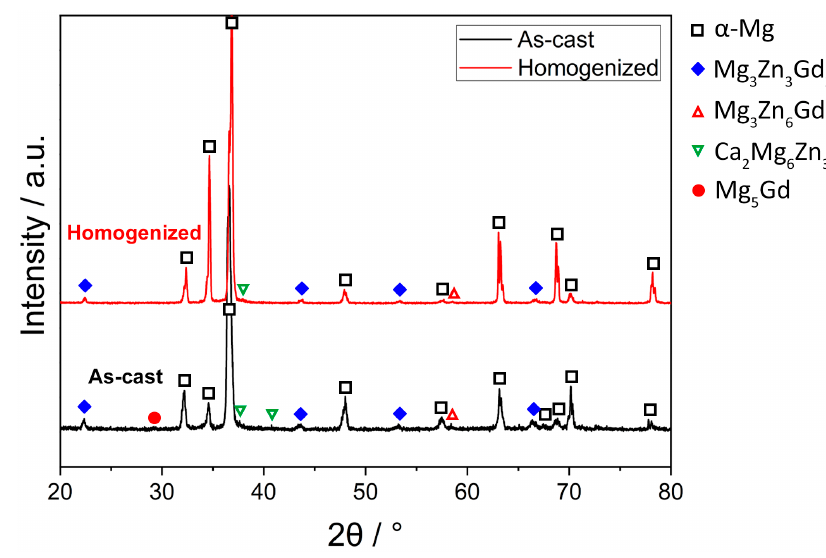
Figure 1. XRD spectra for the as-cast and homogenized alloys.